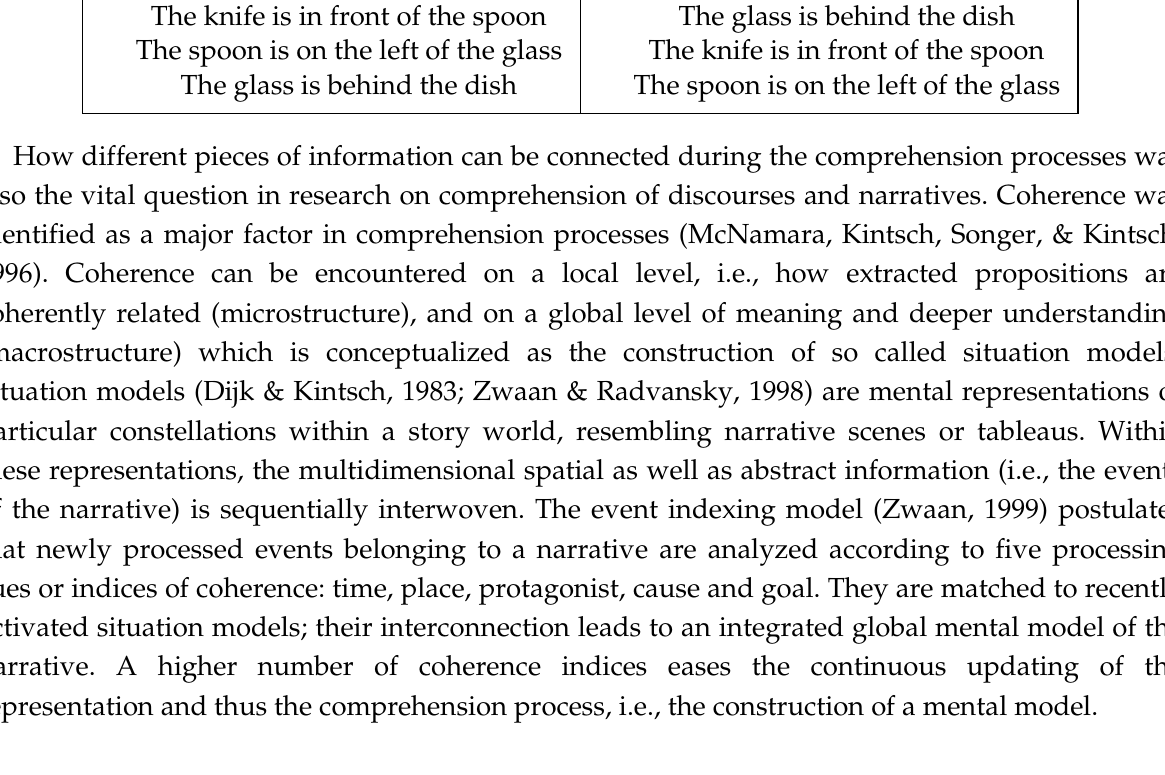
condition A condition B The knife is in front of the spoon The glass is behind the dish The spoon is on the left of the glass